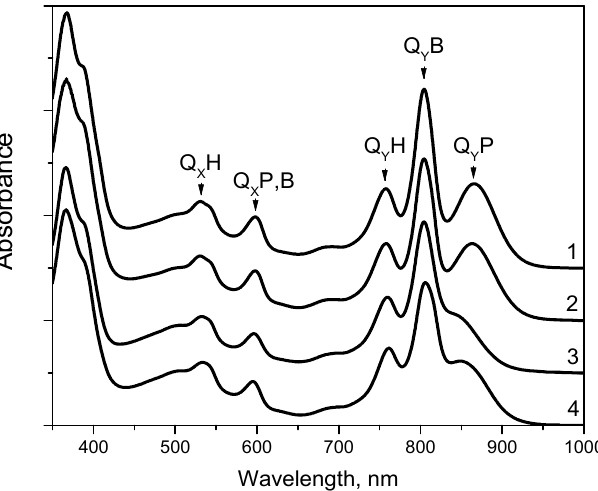
Figure 2. Electronic ground-state absorption spectra of C. sphaeroides reaction center from wild-type (1) and mutant strains F(M197)H (2), I(L177)H (3), and I(L177)H+F(M197)H (4). Spectra were measured at room temperature and normalized at Q Y H absorption band.